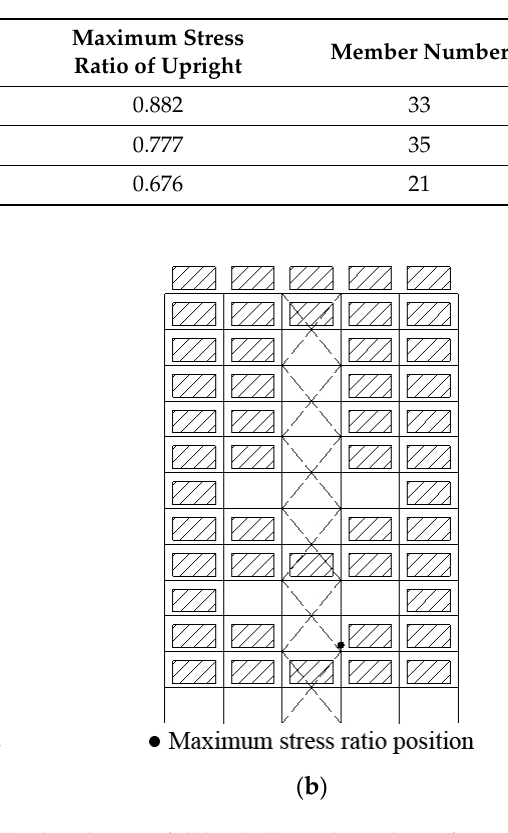
( a ) ( b ) Figure 10. The most favorable distribution of load under 70% full load. ( a ) Tracking chart of optimi- zation performance of GA. ( b ) The most favorable distribution of load (H = 6.24, P = 0.05).